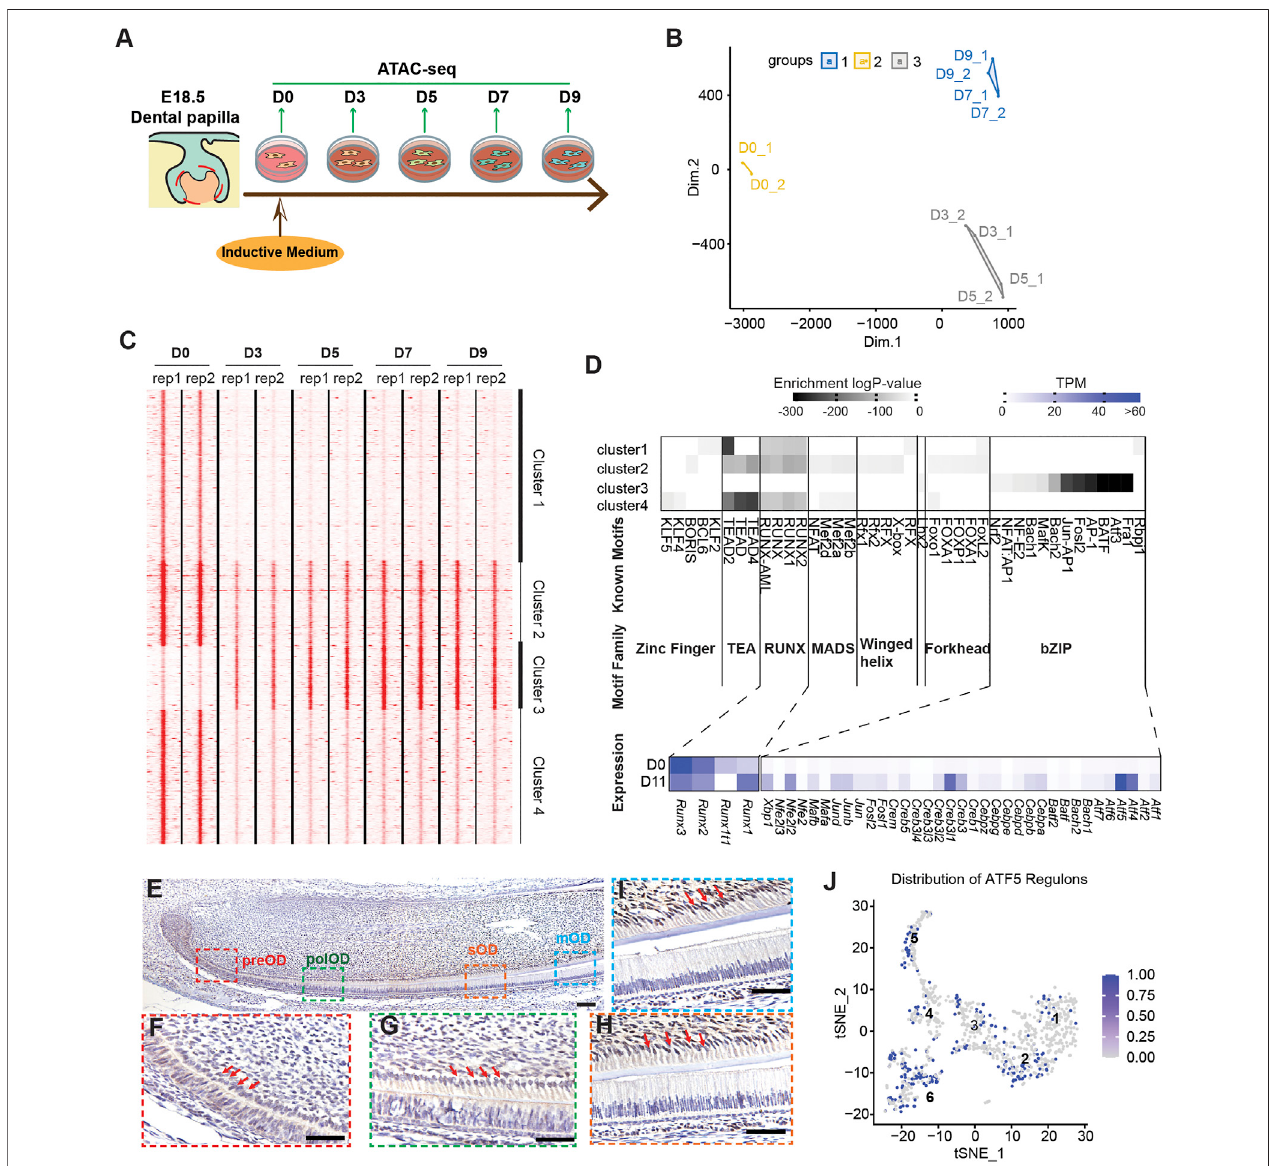
FIGURE3| Time – courseATAC-seqintegratedwithRNA-seqidenti fi edtranscriptionfactors(TFs)enrichedinopenchromatinregionsassociatedwithodontoblast terminal differentiation. (A) Study design for time-course ATAC-seq using in vitro odontoblast differentiation. (B) A multidimensional scaling (MDS) plot showing the difference between differential-enriched NFRs among D0, D3, D5, D7, and D9 ATAC-seq. (C) k-mean clustering of differential-enriched NFRs across replicates and stages, highlighting peak density pro fi le. Each line is centered in NFRs enriched in different stages, with expansion from − 5,000 to +5,000 bp. (D) Top enriched known motifs in each cluster as predicted via Homer analysis. The color gradient indicates the log 10 ( p -value) of enrichment analysis over the total background peaks using binomial testing. Hierarchy clustering of TF distribution based on log 10 ( p -value) was depicted in the heatmap. Coincidently, most of the clustered TFs belong to a speci fi cTFfamilywithasimilarstructure,suchaszinc- fi nger,RUNX,forkhead,orbZIP.Ofnote,thebZIPTFsfamilywasspeci fi callyenrichedincluster3-enrichedNFRs. The average expression of each member in the bZIP family on D0 and D11 bulk RNA-seq pro fi les was exhibited in the heatmap. (E – I) Immunohistochemistry of the expressionpatternofATF5inPN2murinelowerincisor.ATF5expressioninthepre-odontoblasts(preOD) (F) ,polarizedodontoblasts(polOD) (G) ,secretoryodontoblast (sOD) (H) , and mature odontoblast (mOD) (I) were gradually increasing. Scale bar: 100 µm. Red arrows point to the odontoblast layer. (J) tSNE plot showing the distribution of cells with abundant ATF5-targeting genes (regulons) in OC-positive scRNA-seq pro fi le.